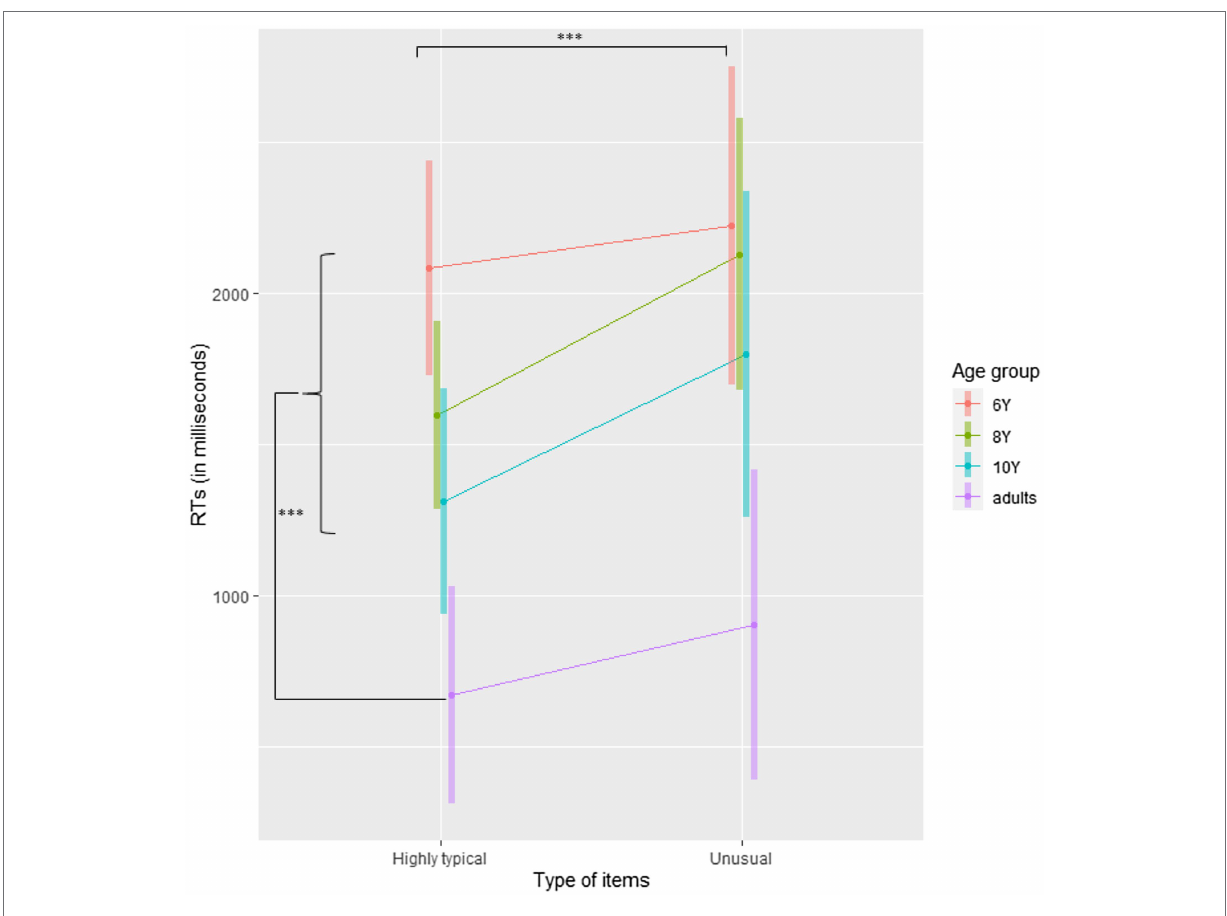
FIGURE 4 | Mean reaction times in Experiment 2 plotted separately for Age group and Type of item. Error bars are 95% CI. *** p <